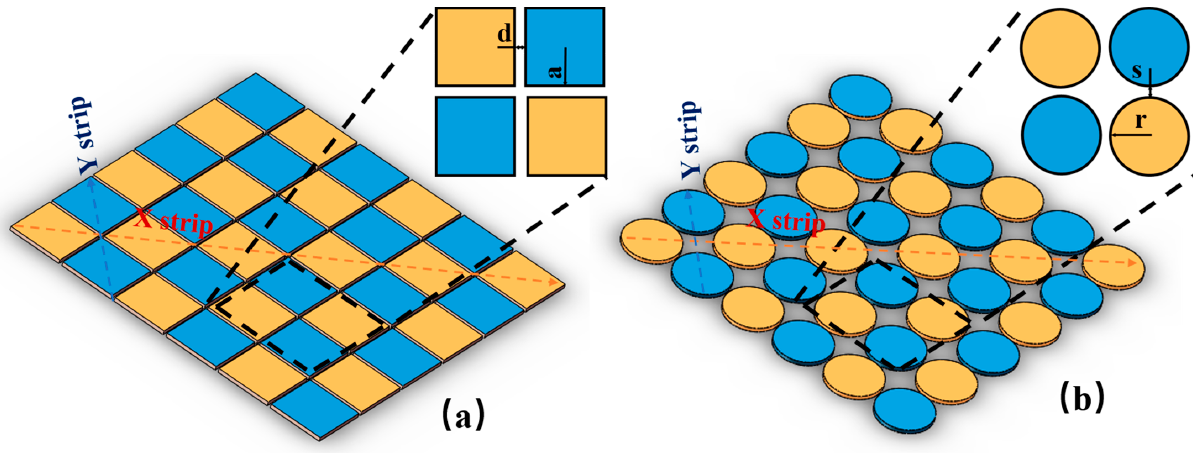
Figure 1. Highly symmetrical structural design for detector pads. ( a ) is a symmetric structure composed of square cells. ( b ) is a symmetric structure composed of circle cells.